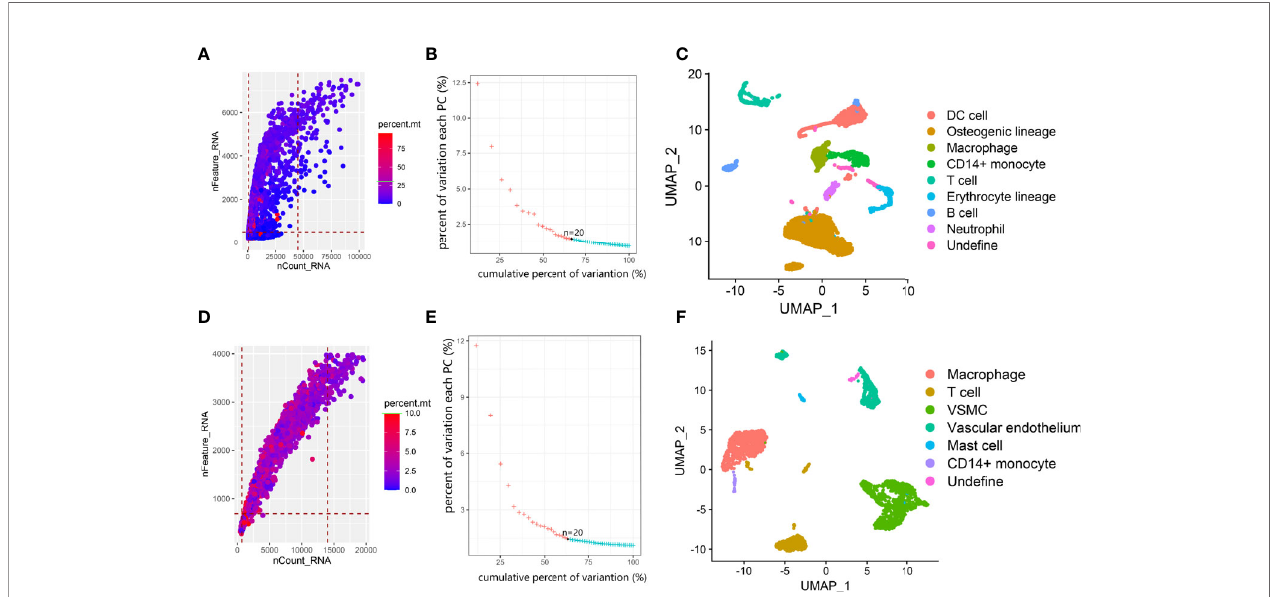
FIGURE 2 | Overview of data processing and cell annotation in scRNA data. (A, D) Dot plot of data quality control in scRNA data. (B, E) elbow plot showing the percent of variation and cumulative percentages associated with each PC in scRNA data. (C, F). UMAP plot showing clusters of main cell types from osteoporosis and atherosclerosis scRNA-seq datasets.